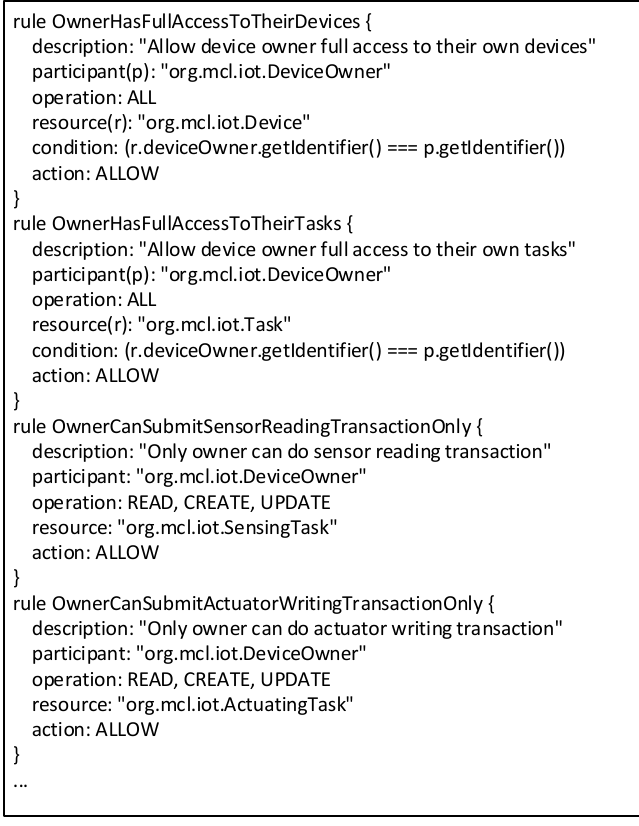
Table 1. Sample RESTful API endpoints in the business network.